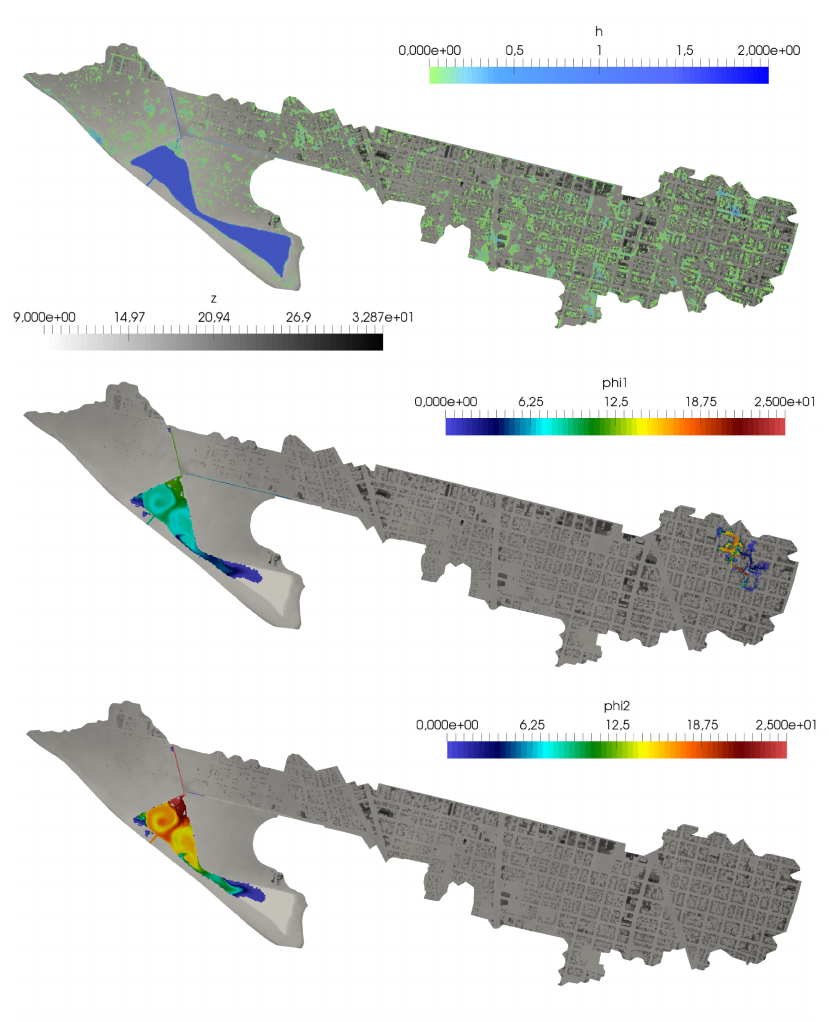
Figure 20. Case 3: Surface water depth h ( upper ) and pollutant concentration for both solutes φ 1 ( center ) and φ 2 ( lower ) at t = 5.2